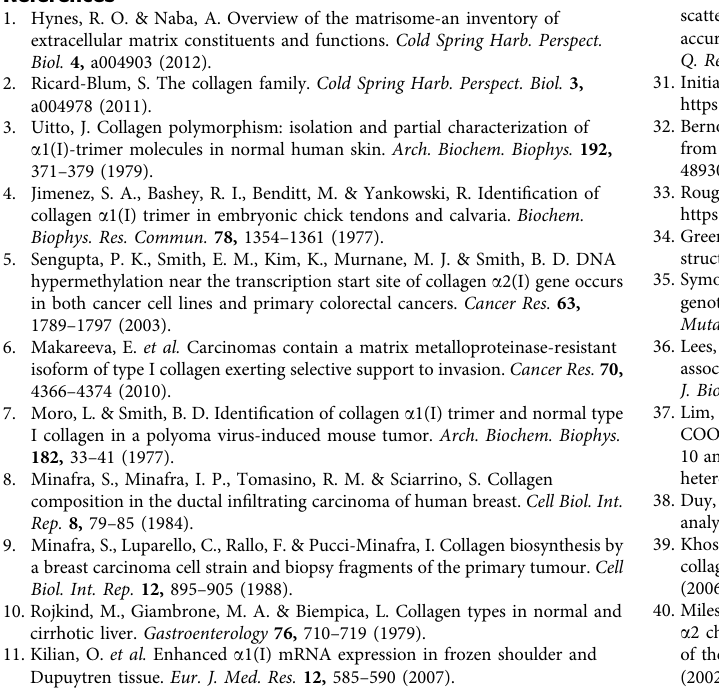
Figure rendering and homology modelling . Sequence alignment was carried out using the programme MUSCLE 65 or the NPS@: Network Protein Sequence Analysis server 66 using sequence data from the UniProt 67 and SMART 68 databases. Structure-based alignment was performed and rendered using the programmes ESPript 3.0 and ENDscript 2.0 (ref. 69). Protein structures were drawn using the programme PyMOL (Version 1.4.1, Schro¨dinger, LLC). For modelling of hetero-CPI, all residues in the two interface regions of one of the chains in homo-CPI were first mutated manually to the corresponding residues in the a 2(I) chain (Supplementary Fig. 2), using the ‘mutagenesis’ function in PyMOL , then the overall model was energy minimized with PHENIX 70 . Data availability . The coordinates and structure factors of homo-CPI have been deposited in the Protein Data Bank (http://www.rcsb.org/pdb) with accession number 5K31. Any additional data not shown in this published article or in its Supplementary Information are available from the corresponding authors on reasonable